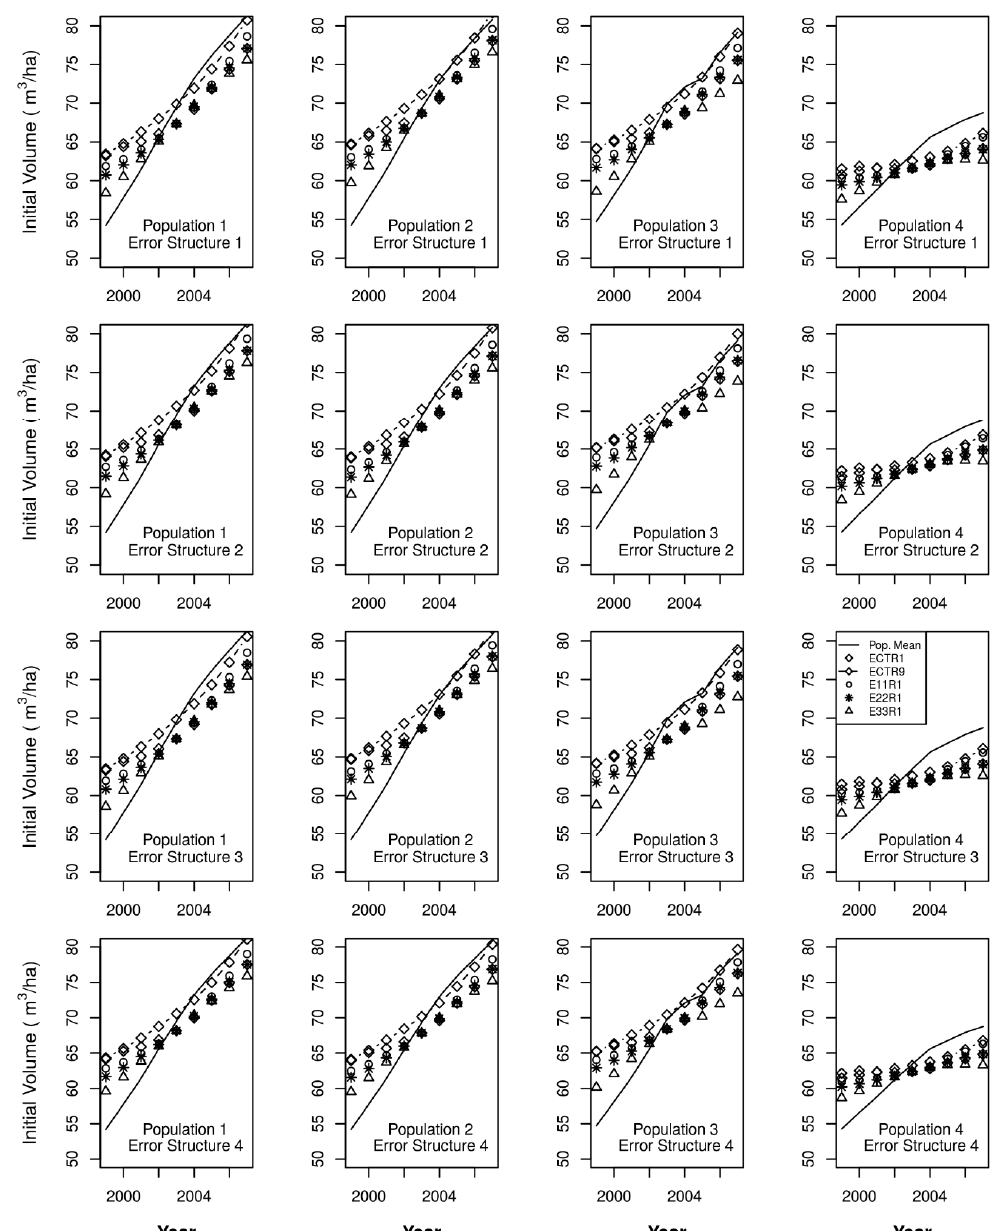
Figure 6. The means of the initial volume estimators relative to the population initial volumes over 1000 iterations of 1000 samples for each population and sample error